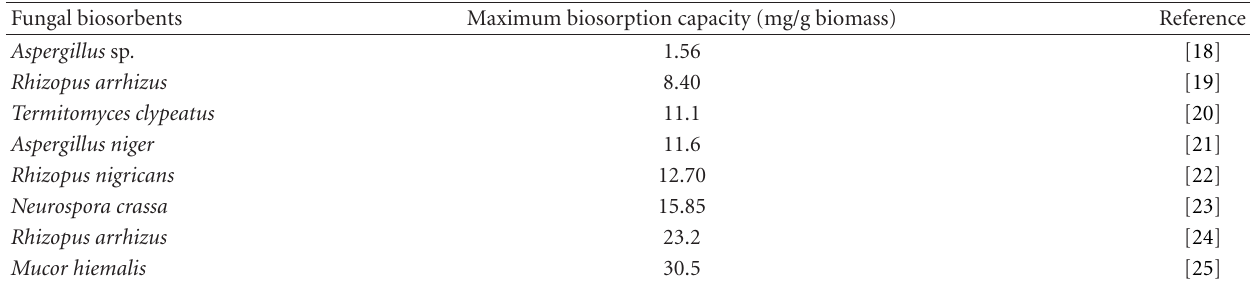
Table 1: Comparison of various fungal biomasses for Cr(VI) biosorption.